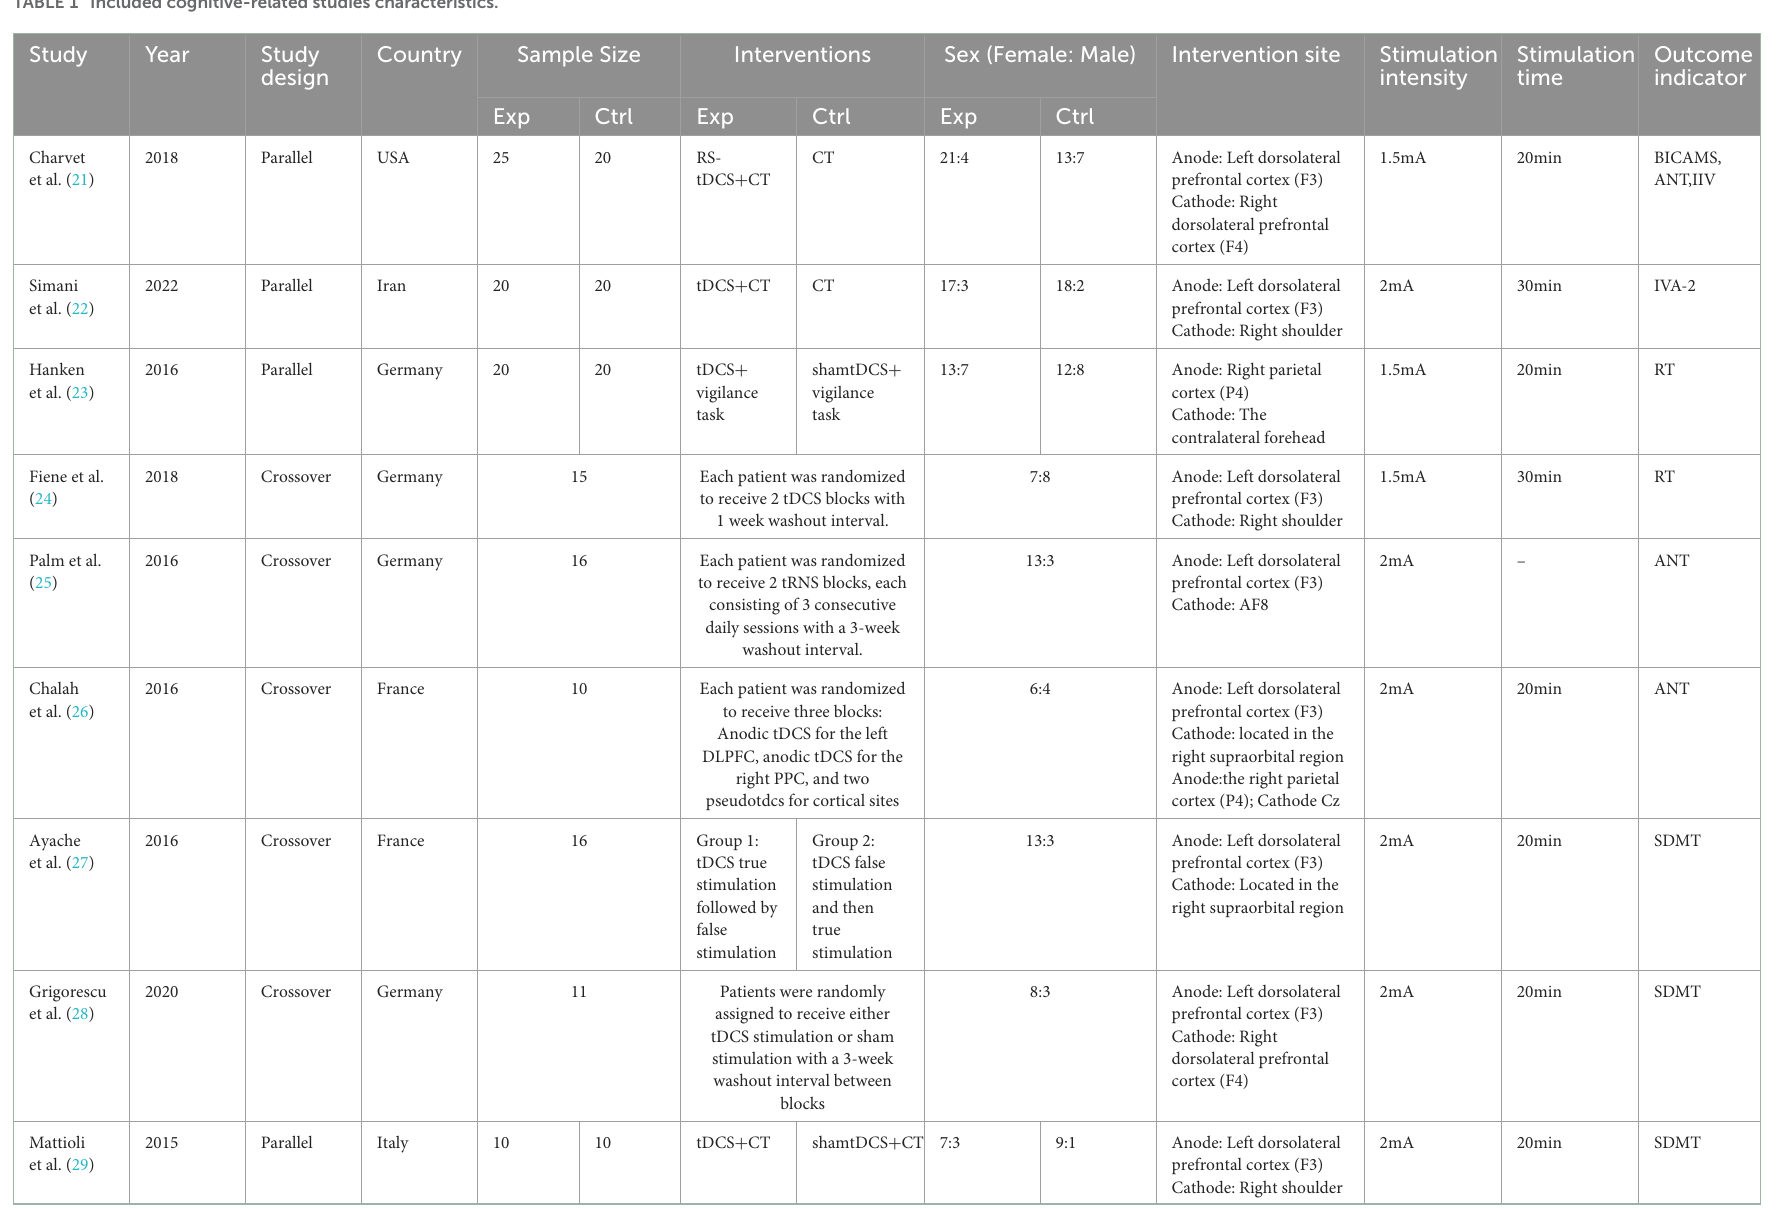
TABLE 1 Included cognitive-related studies